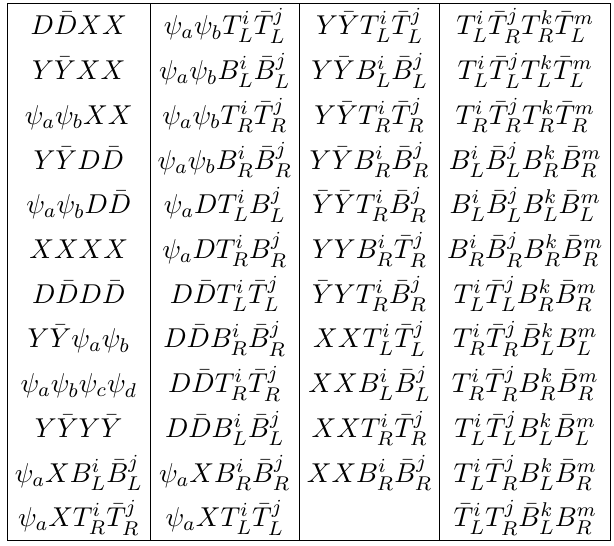
Table 10 . Dimension-6 operators of fermions for LHC phenomenology. Here, the superscript i refers to unprimed, primed, or double primed for the three generations of top and bottom quarks, and the subscript a ranges over 1 ; 2 ; 3 for the three neutral fermions.